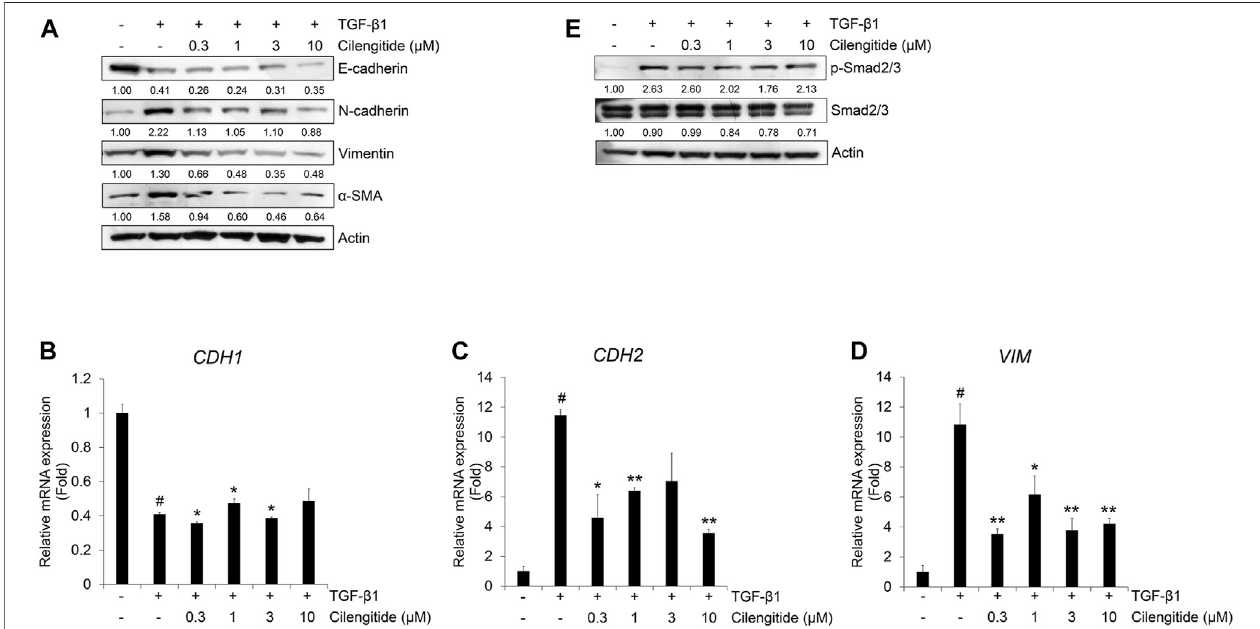
FIGURE 5 | Combination of ge fi tinib with cilengitide shows enhanced inhibitory effects on TGF- β 1-induced EMT expression and Smad signaling. A549 cells were treatedwithge fi tinib(1µM)andcilengitide(3µM)individuallyorincombination,andthenincubatedwithTGF- β 1(5ng/mL)for72h (AandB) or48h(C)or24h (DandE) . The expression of EMT markers (A) and phosphorylation of Smad2/3 (C) were measured by western blot analysis. Actin was used as a loading control. (B) The expression of vimentin was measured by immunocytochemistry. Nuclei were counterstained with DAPI. Scale bars = 100 µm. (D and E) After RNA extraction and cDNAsynthesis,weperformedqRT-PCRtomeasuretheexpressionof CDH2 and VIM mRNAusingGAPDHasaninternalcontrol. # p < 0.01vs.control;* p < 0.05,** p < 0.01 vs. the group treated with TGF- β 1